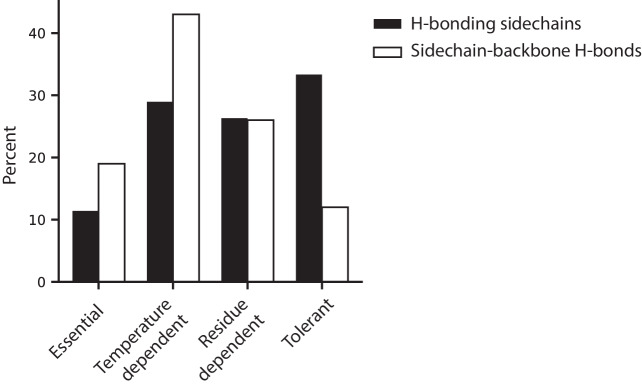
Hydrogen bonding behavior in relation to temperature dependence classifications.A comparison of proportion of h-bonding sidechains to the proportion of sidechain-backbone h-bonds within each temperature dependent classification (determined from the wtVIM-2 crystal structure, PDB: 5yd7). The black bars display the percentage of h-bonding sidechains within the wtVIM-2 catalytic domain (114 total) that fall within each temperature dependence classification. The white bars show the percentage of sidechain-backbone h-bonds (73 total) that are formed through sidechains of residues with the classification. All h-bonding in the 5yd7 structure can be found in Supplementary file 2G.